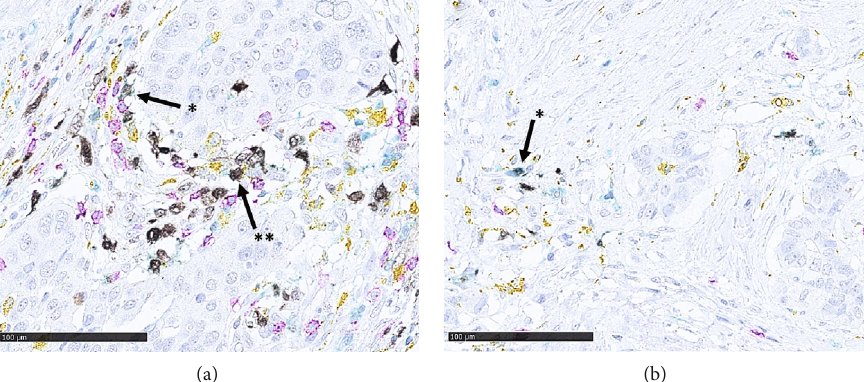
Figure 3: Multicolor immunohistochemistry for IDO (black signals), CD4 (teal/blue signals), CD8 (purple signals), and CD68